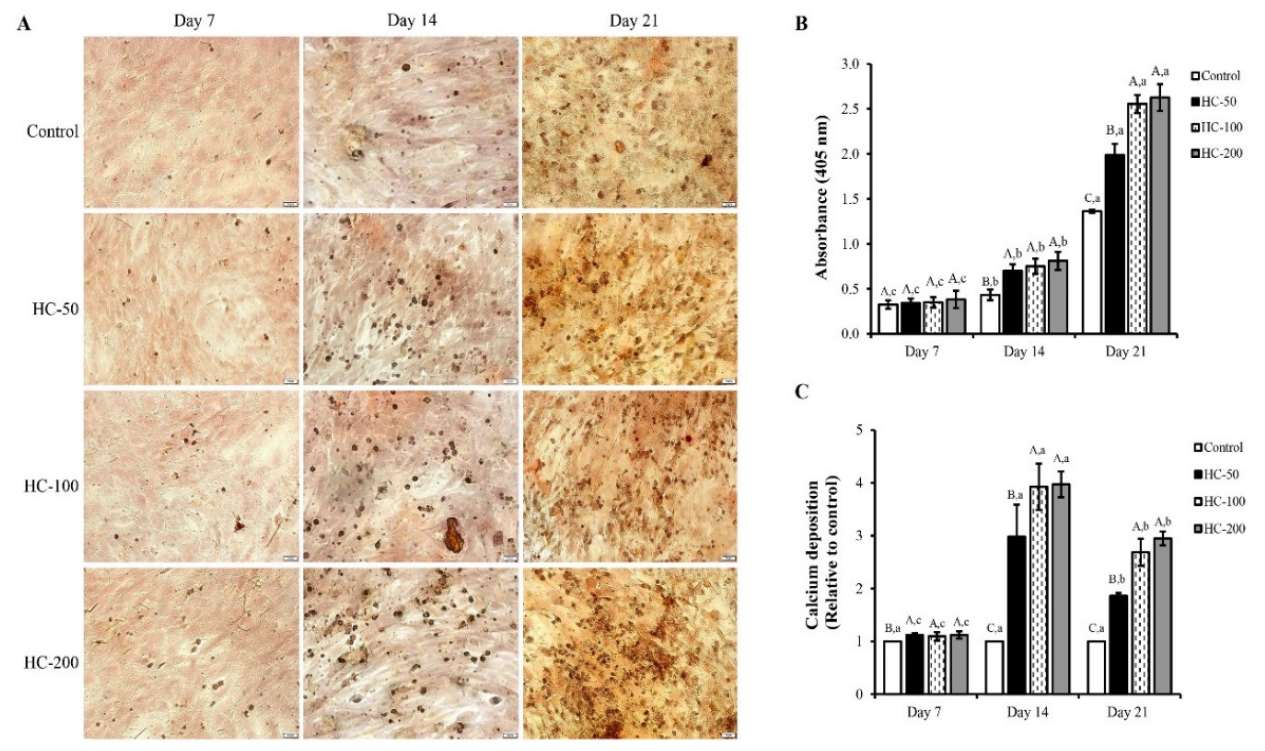
Figure 4. Effect of defatted sea bass skin hydrolyzed collagen (HC) on ( A ) mineralization of MC3T3-E1 cells (scale bar = 100 µm; magnification = ×10) as indicated by ( B ) changes in absorbance at 405 nm and ( C ) calcium deposition during 21 days. Relative calcium deposition was assessed using ImageJ software. Error bars represent standard deviations ( n = 3). Different uppercase letters indicate significant differences between samples at the same culture time ( p < 0.05). Different lowercase letters indicate significant differences between culture times of the same sample ( p < 0.05).